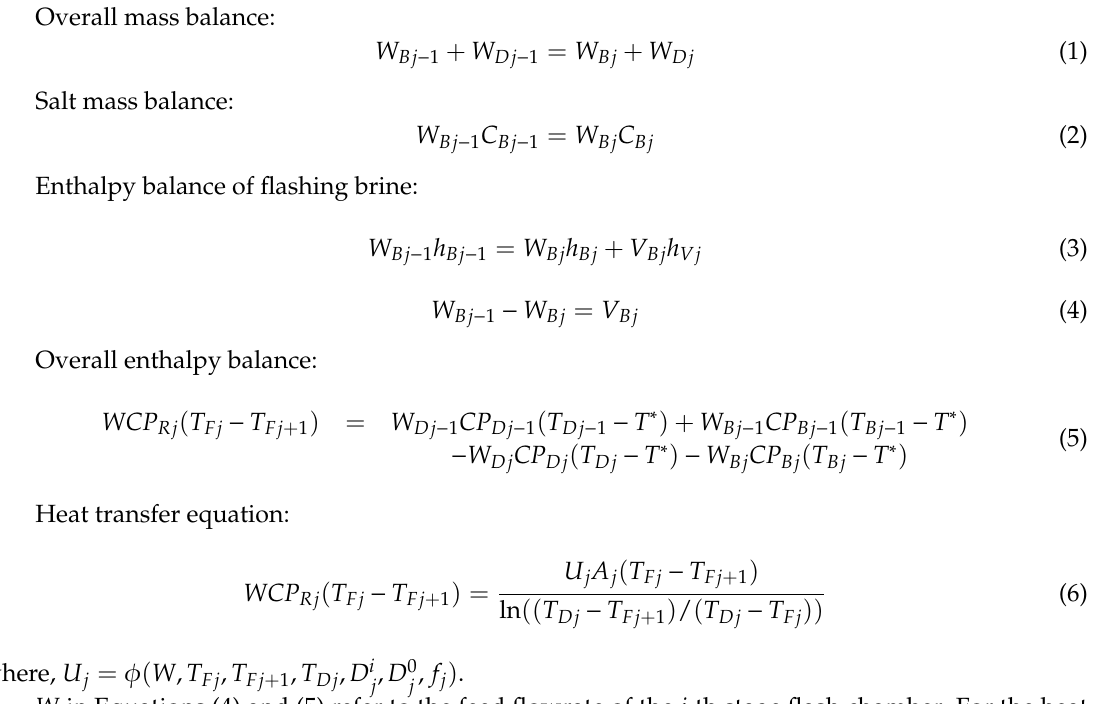
Figure 2. Flowrate relations of the j -th stage flash chamber in an MSF system.